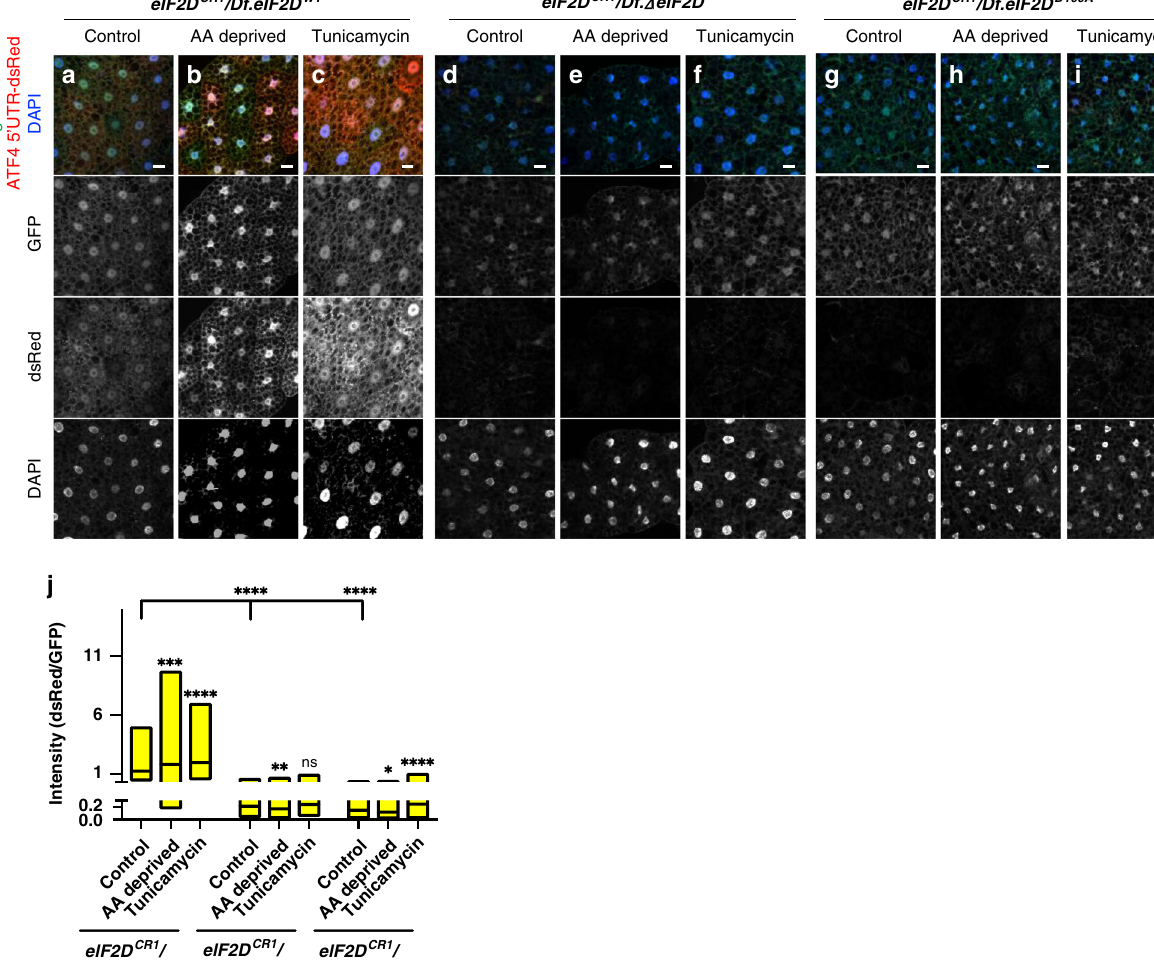
Fig. 6 eIF2D and DENR regulate the translation of the ATF4 ORF. a – i Expression of the ATF4 5 ′ UTR-dsRed reporter in fat bodies of control ( Df.eIF2D WT ), eIF2D transheterozygous null ( Df. Δ eIF2D ) and point ( Df.eIF2D D109A ) mutants. The reporter utilizes a dsRed reporter bearing a nuclear localization sequence. Control GFP expression is driven by Dcg-GAL4 . Larvae in b , e , h were subjected to 4 h of amino acid deprivation and those in c , f , i were fed Tunicamycin for 4 h. Data are representative images collected from two independent biological experiments with ten animals in each trial. j Quanti fi cation of the ATF4 5 ′ UTR-dsRed reporter intensities normalized to corresponding GFP intensities from the same cells. Midline represents the mean value, with the top and bottom of the box representing the maximum and minimum values. Asterisks above the boxes represent statistical signi fi cances between mutant and control values calculated with the a two-tailed t -test with *** p < 0.0001 and * p < 0.01. n = 158, 157, 112, 104, 139, 131, 120, 148, and 137, respectively for each box from left to right. Please see Source Data Files for raw